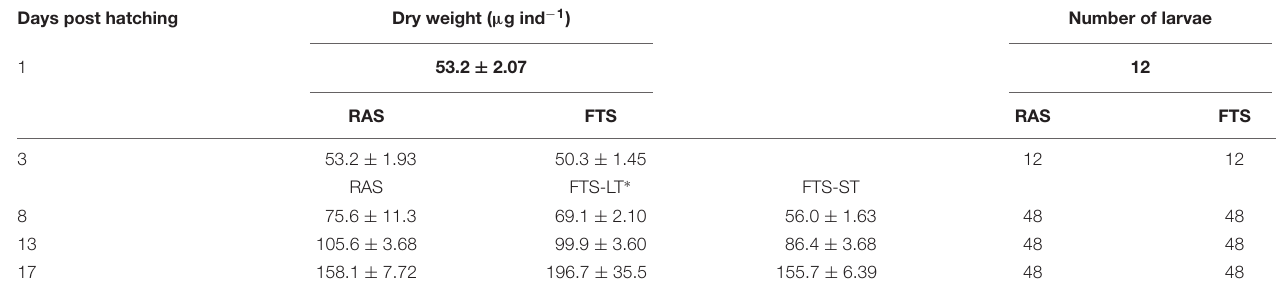
TABLE 1 | Average cod larvae dry weight ( µ g ind − 1 ).